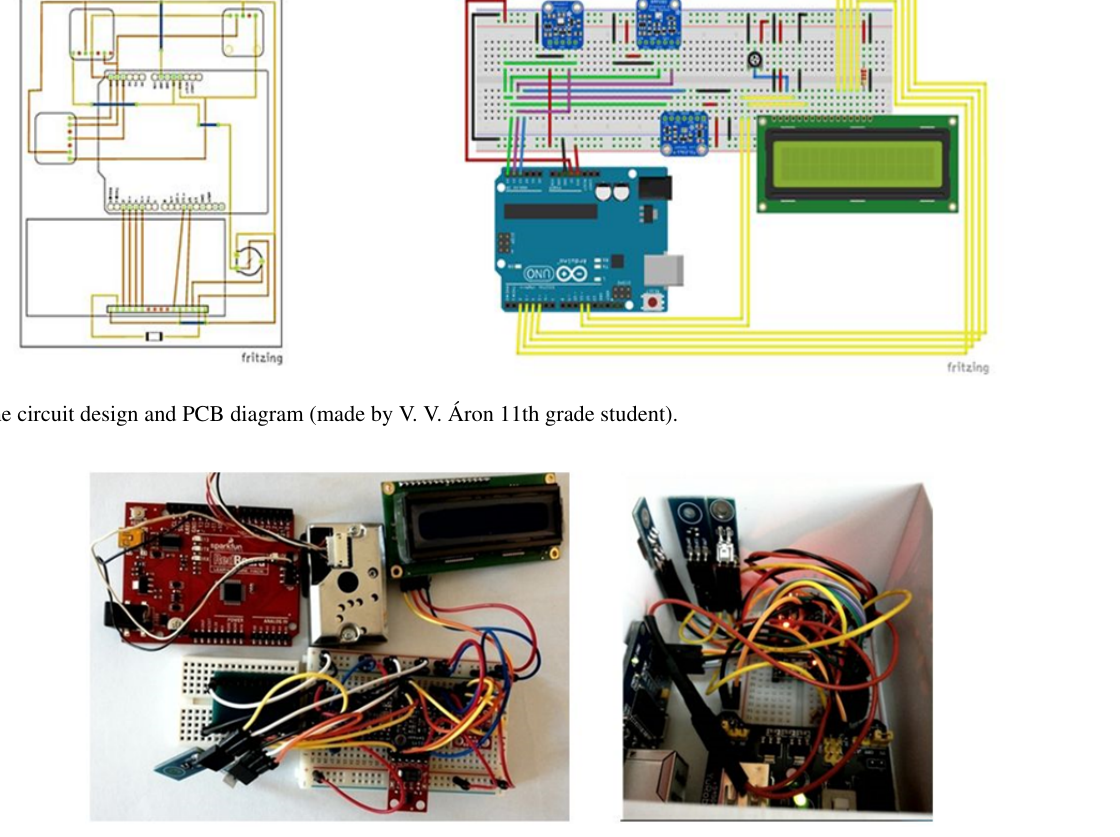
Figure 4. The testing module and the fixed mini meteo station (near the physics